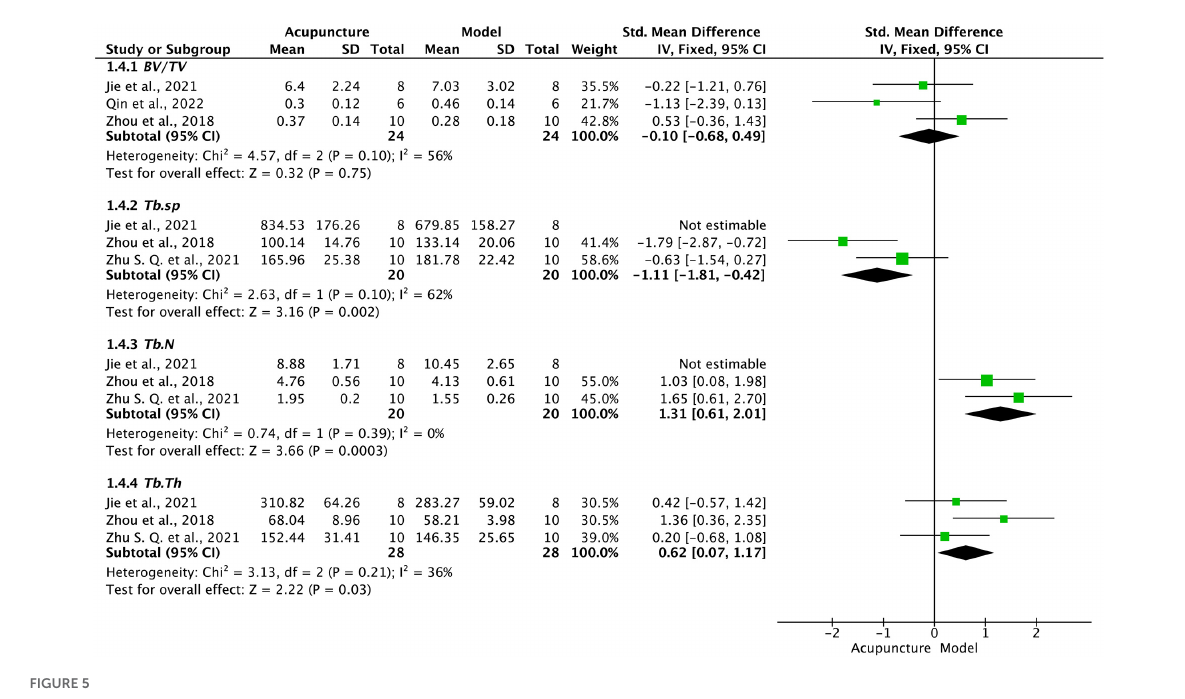
FIGURE5 Forest plot of morphometry of